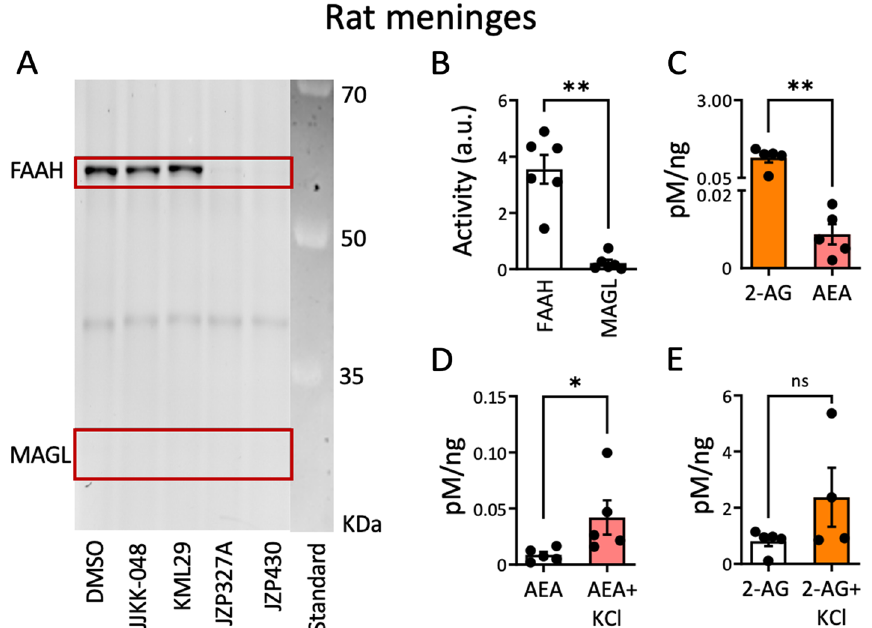
Fig. 1 Competitive gel‑based ABPP reveals higher FAAH over MAGL activity in rat meninges and LC–MS/MS shows 2‑AG as the main meningeal endoCB. A Rat meninges were pre‑incubated for 1 h with DMSO (vehicle), MAGL‑inhibitors JJKK‑048 (100 nM) and KML‑29 (1 μM) and FAAH‑inhibitors JZP‑327A (1 μM) and JZP‑430 (1 μM), and then labelled with fluorescent probe TAMRA‑FP, as indicated in the Methods. TAMRA‑FP‑labelled bands appear dark after in‑gel imaging. FAAH and MAGL were identified based on selective inhibition and their expected molecular weights. MAGL and FAAH band‑intensities after DMSO treatment represent basal MAGL and FAAH activities, respectively. Note that FAAH activity after DMSO treatment is high, whereas basal MAGL activity is practically absent. Basal FAAH‑ activity was reduced with JZP‑327A ( N Friedman test) and with JZP‑430 ( N 6, Friedman test). MAGL‑inhibitors JJKK‑048 (100 nM) and KML‑29 (1 μM) did not affect FAAH basal activity. B = Statistics comparing the basal activity of MAGL and FAAH in rat meninges. Basal FAAH activity was higher than MAGL activity ( N U test, ** 0.002). C LC–MS/MS data comparing AEA and 2‑AG levels in naïve rat meninges. The level of 2‑AG was much higher than that of AEA = ( N 5, Mann Whitney U test, ** 0.002). D LC–MS/MS data comparing AEA levels in naïve rat meninges vs. after 4 h incubation of 100 mM KCl = = pro‑nociceptive treatment. KCl treatment significantly increased AEA levels compared to its basal level (